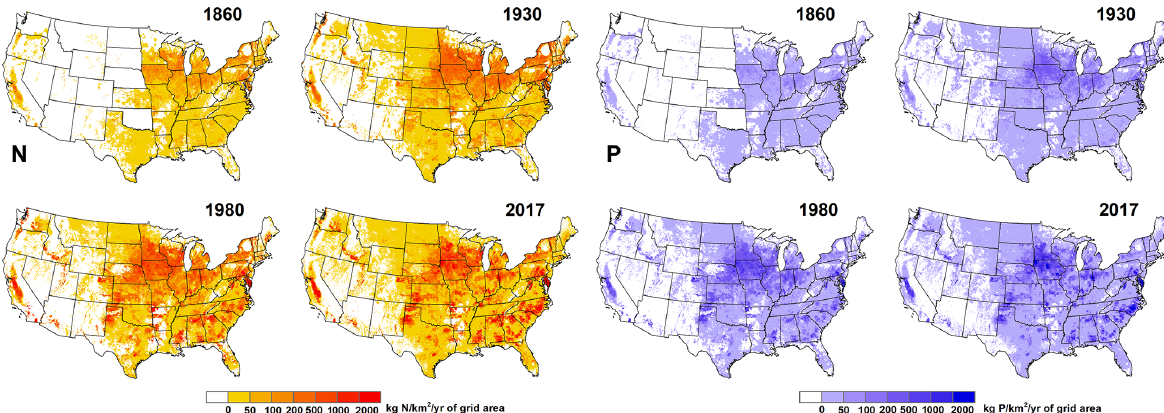
Figure 7. Spatial distributions of manure N and P application in the US cropland in 1860, 1930, 1980, and 2017.